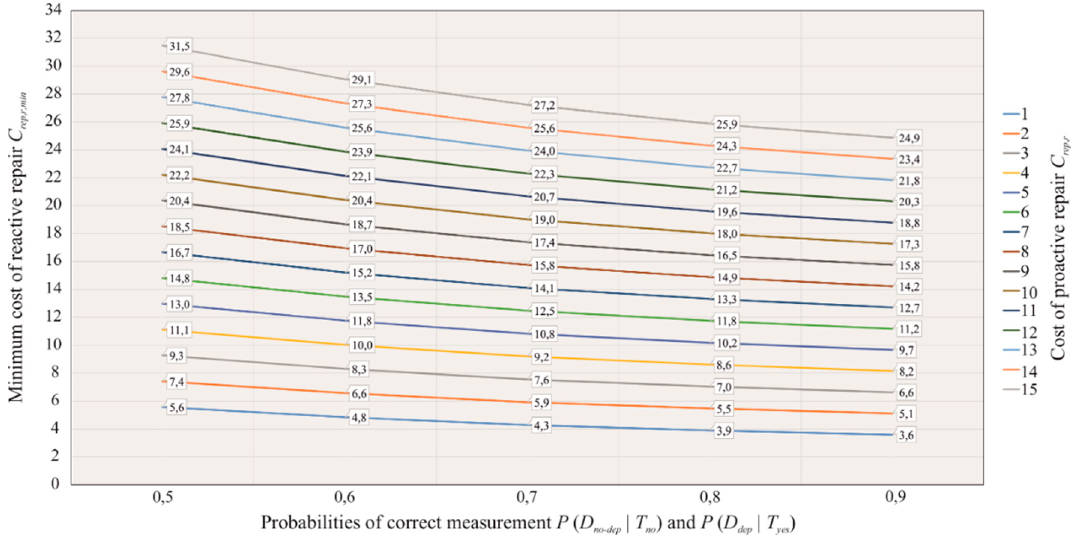
Figure 3. Minimum cost of reactive repair, C rep,r,min , for different probabilities of correct measurements, P ( D no-dep | T no ) and P ( D dep | T yes ), given the cost of measurement, C meas = 1, and the probability of depassivation, P dep = 0.6.